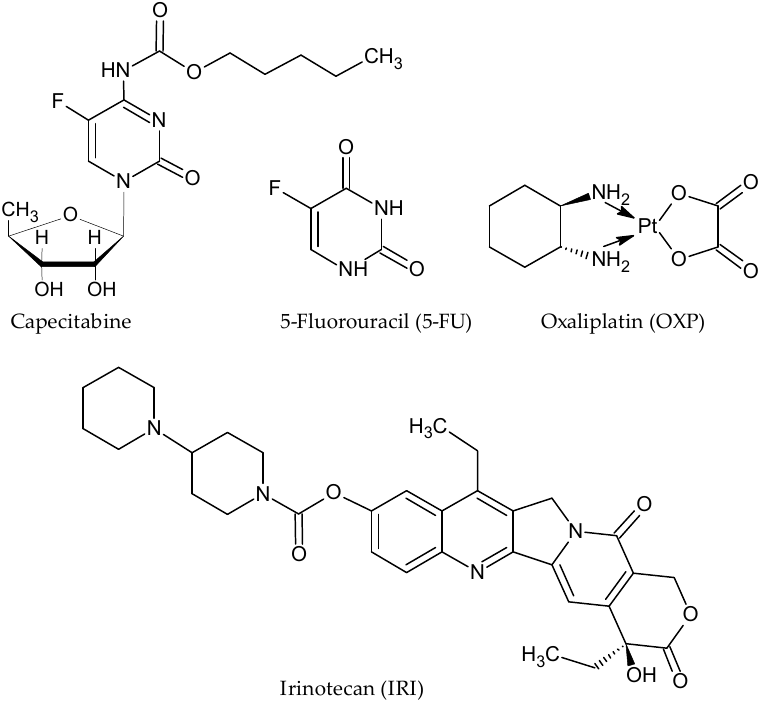
Figure 1. Structure of conventional chemotherapeutic agents administrated in CRC.